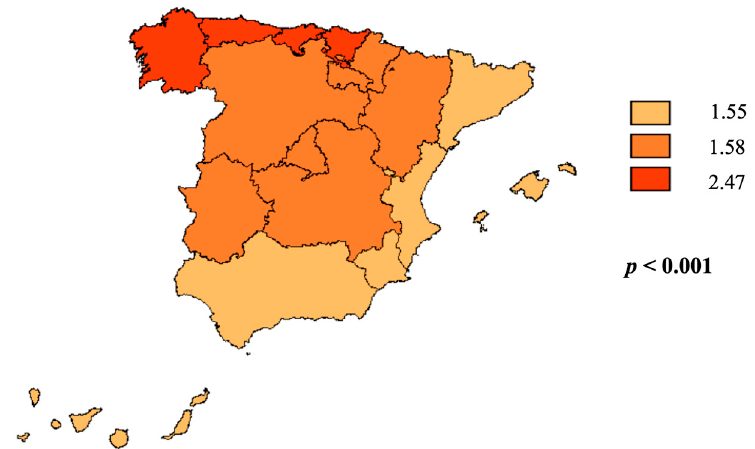
Figure 2. Incidence of infective endocarditis classified by location in Spain from 1997 to 2014. The units of measure for incidence are cases per 100,000 habitants. North: Atlantic weather characterized by a large proportion of humidity and precipitations. Center: Continental plateau with fewer precipitations. South: the Mediterranean with almost no precipitations, higher temperature, and longer sunny days.